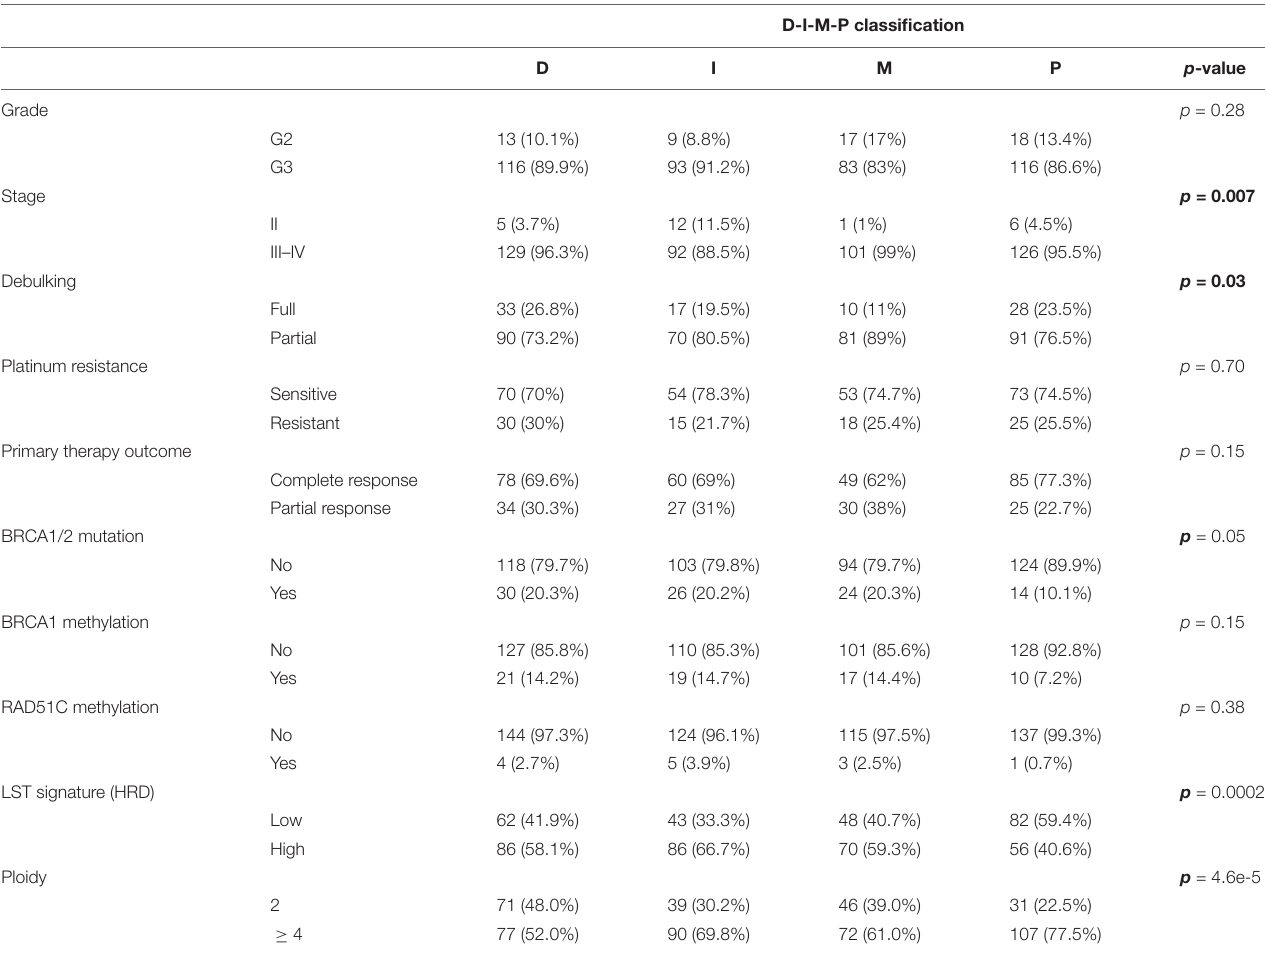
Contingency table showing the association between Fibrosis/non-Fibrosis (two subgroups, Mateescu’s classification), or D-I-M-P subgroups (four subgroups, Verhaac’s classification), and clinical parameters. Data are from the TCGA cohort and the number of patients and frequencies in the population are indicated. Debulking status was defined as full when no macroscopic residue was detected after surgery or as partial otherwise. Response to primary therapy was considered as partial if the patient indicated with partial response, stable disease or progressive disease, considering both surgery efficiency and sensitivity to chemotherapies. P-values are calculated using Fisher’s exact test without correction and significant p-values are indicated in